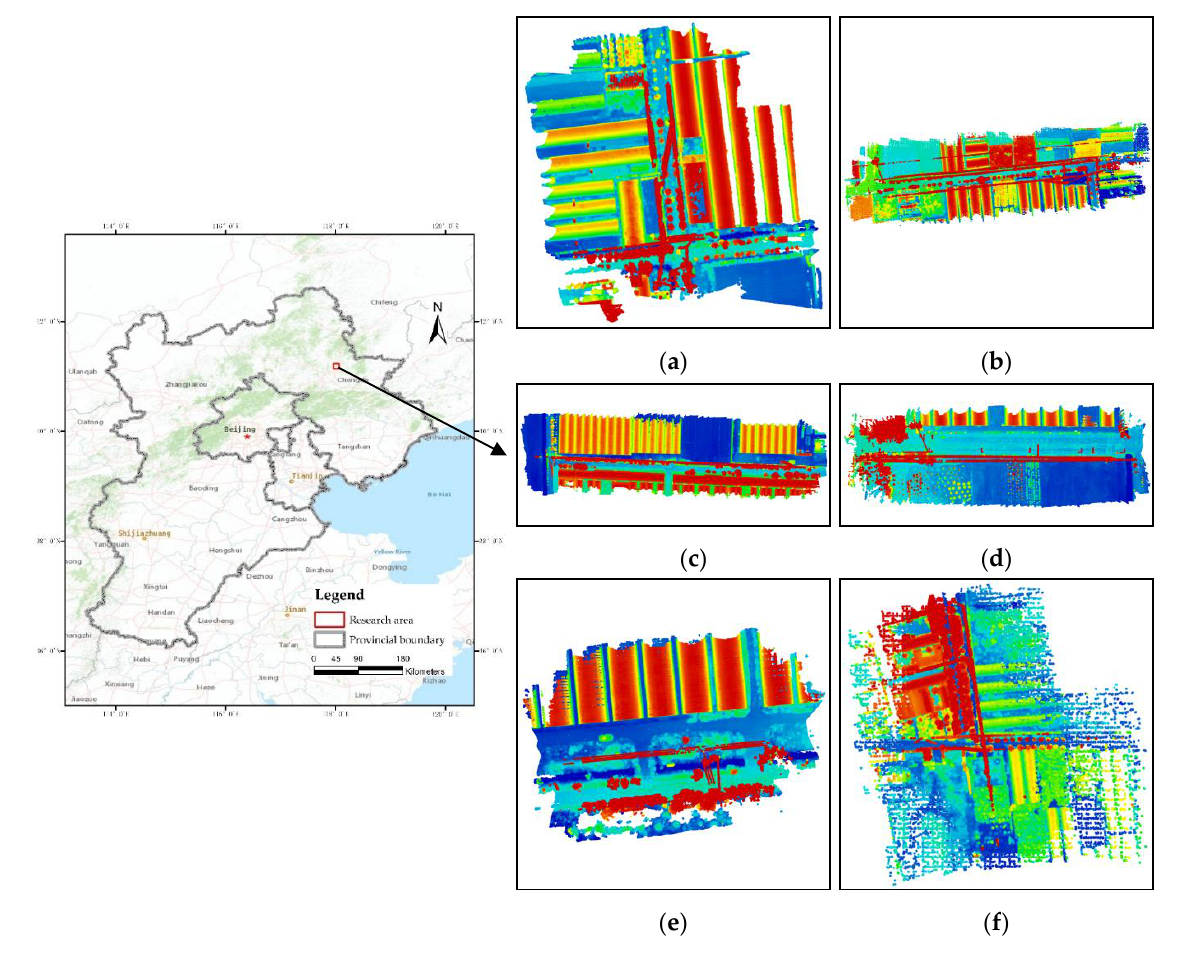
Figure 1. Overview of the research area. ( a ) Dataset-I. ( b ) Dataset-II. ( c ) Dataset-III. ( d ) Dataset-IV. ( e ) Dataset-V. ( f ) Dataset-VI. Table 1. Details of the six datasets.